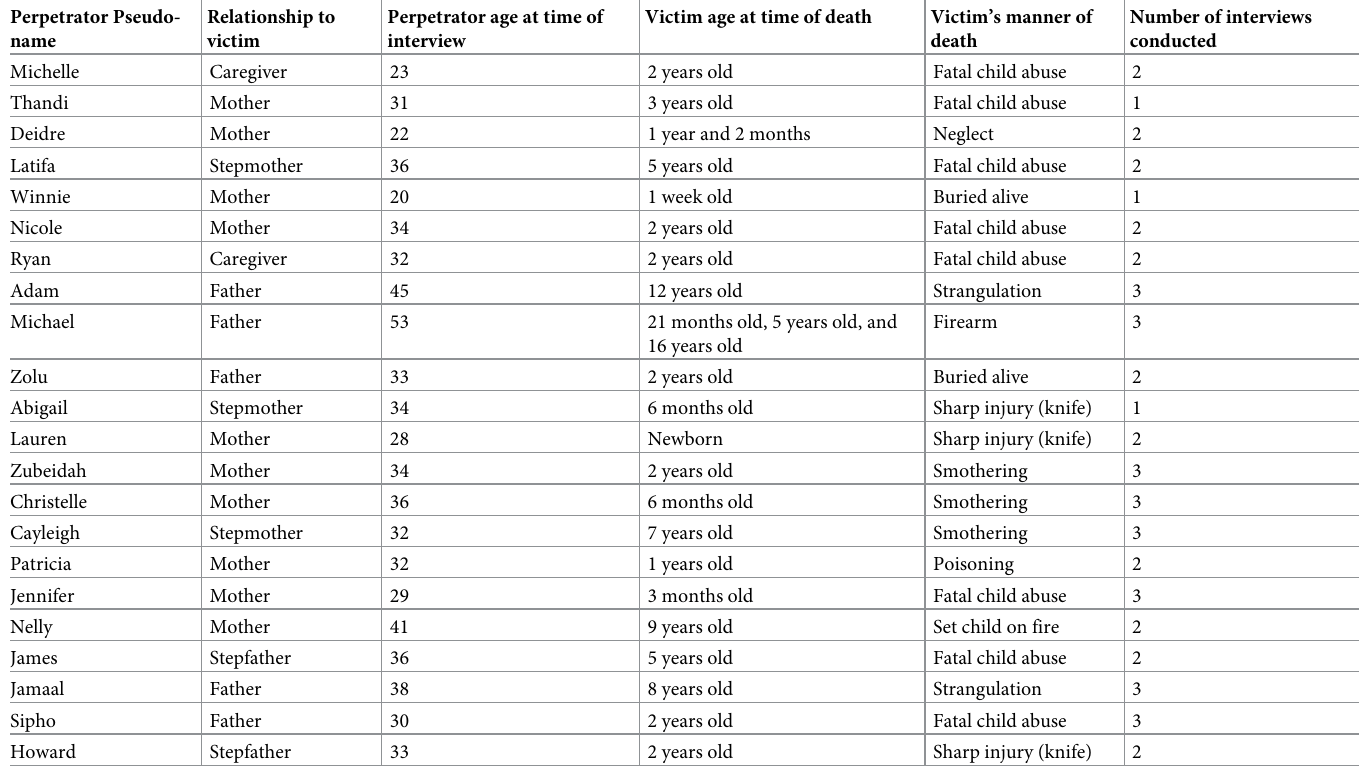
Table 1. Description of perpetrators and